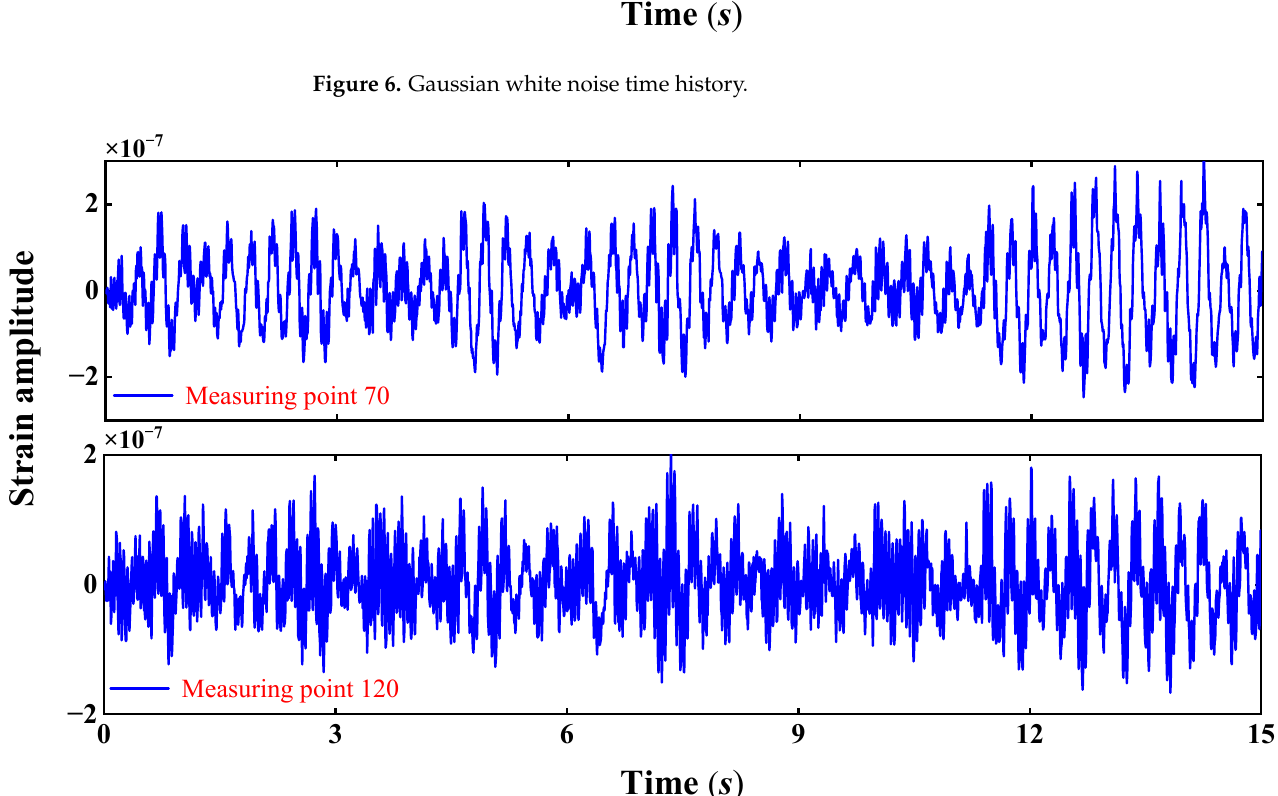
Figure 7. Strain response of cracked cantilever beam under scenario I.